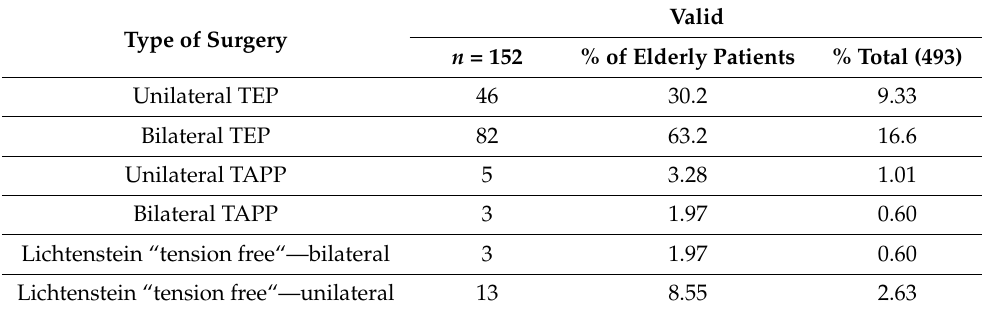
Table 3. Number of elderly patients according to the type of surgery.